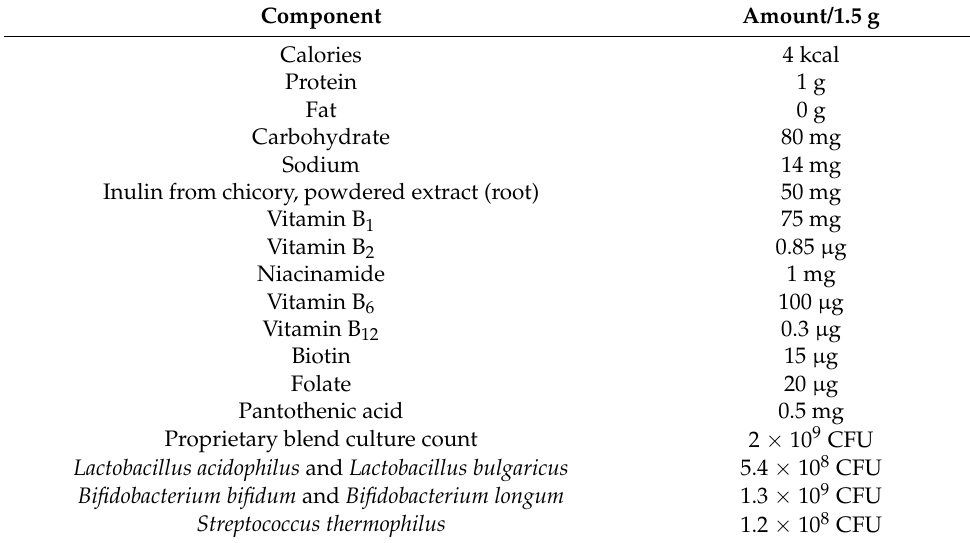
Table 7. The components of synbiotic powder 1,2